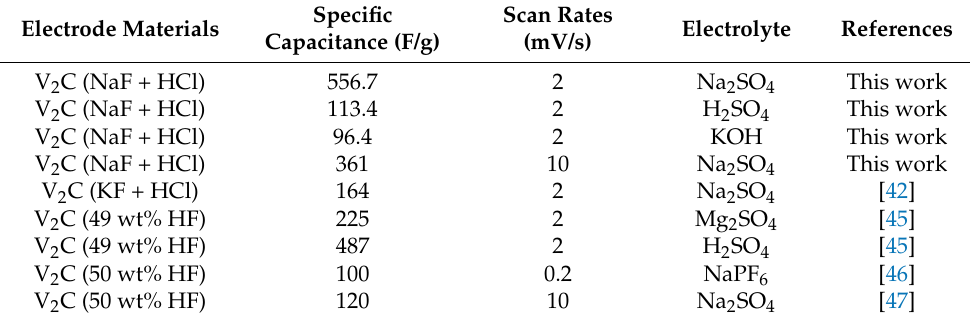
Figure 6. Cyclic voltammograms of V 2 C electrodes at different scan rates ( a ) 1 M Na 2 SO 4 electrolyte, Table 3. The specific capacitance of different V 2 C